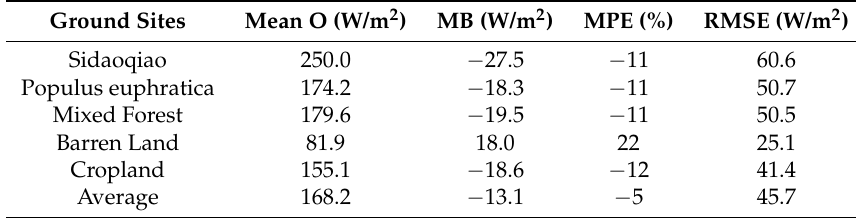
Figure 5. Comparison of instantaneous LE predictions using the SADFAET and ESTARFM with LE measured by EC. Table 7. Error metrics of the LE fused by the SADFAET with the ground-based EC measurement.